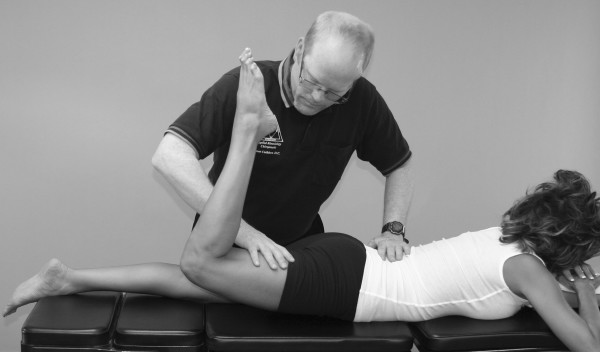
Gluteus Maximus MMT.